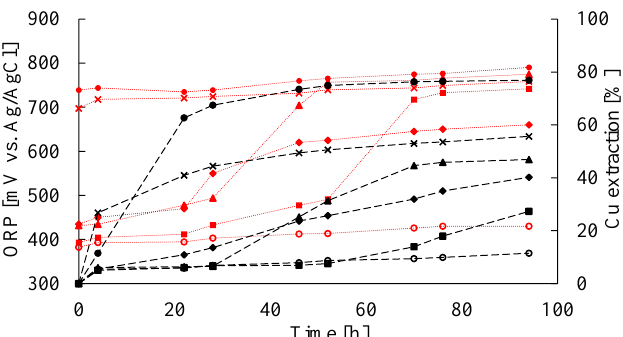
Figure 2. Dissolution of copper (%) from chalcopyrite concentrate and averaged ORP (mV vs. Ag / AgCl) values over time (hours) for Series I at different concentrations of H 2 SO 4 and NaNO 3 . ( ○ ) Test 1 (H 2 SO 4 = 0.1M and NaNO 3 = 0.1M); ( ■ ) Test 2 (H 2 SO 4 = 0.1M and NaNO 3 = 0.5M); ( ▲ ) Test 3 (H 2 SO 4 = 0.5M and NaNO 3 = 0.1M); (●) Test 4 (H 2 SO 4 = 0.5M and NaNO 3 = 0.5M); (X) Test 5 (H 2 SO 4 = 1.0M and NaNO 3 = 0.1M); ( ◆ ) Test 6 (H 2 SO 4 = 0.5M and NaNO 3 = 0M). (Test conditions: 94 h, P80 = 60.66 µm, 450 rpm and room temperature). The copper recoveries are showing with black dotted line in axis secondary and averaged ORP values are showing with red dotted line.